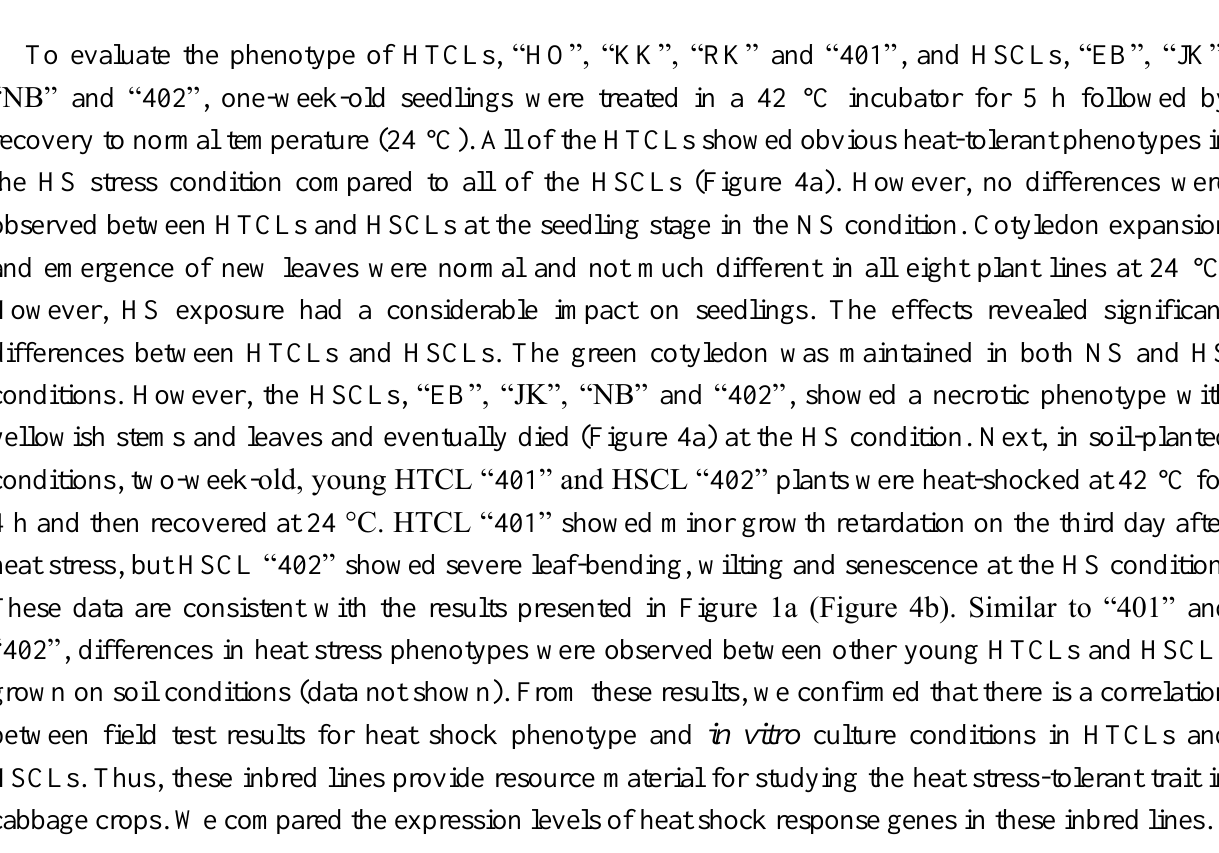
Figure 4. Heat stress phenotypes of heat-tolerant or heat-sensitive inbred cabbages. ( a )